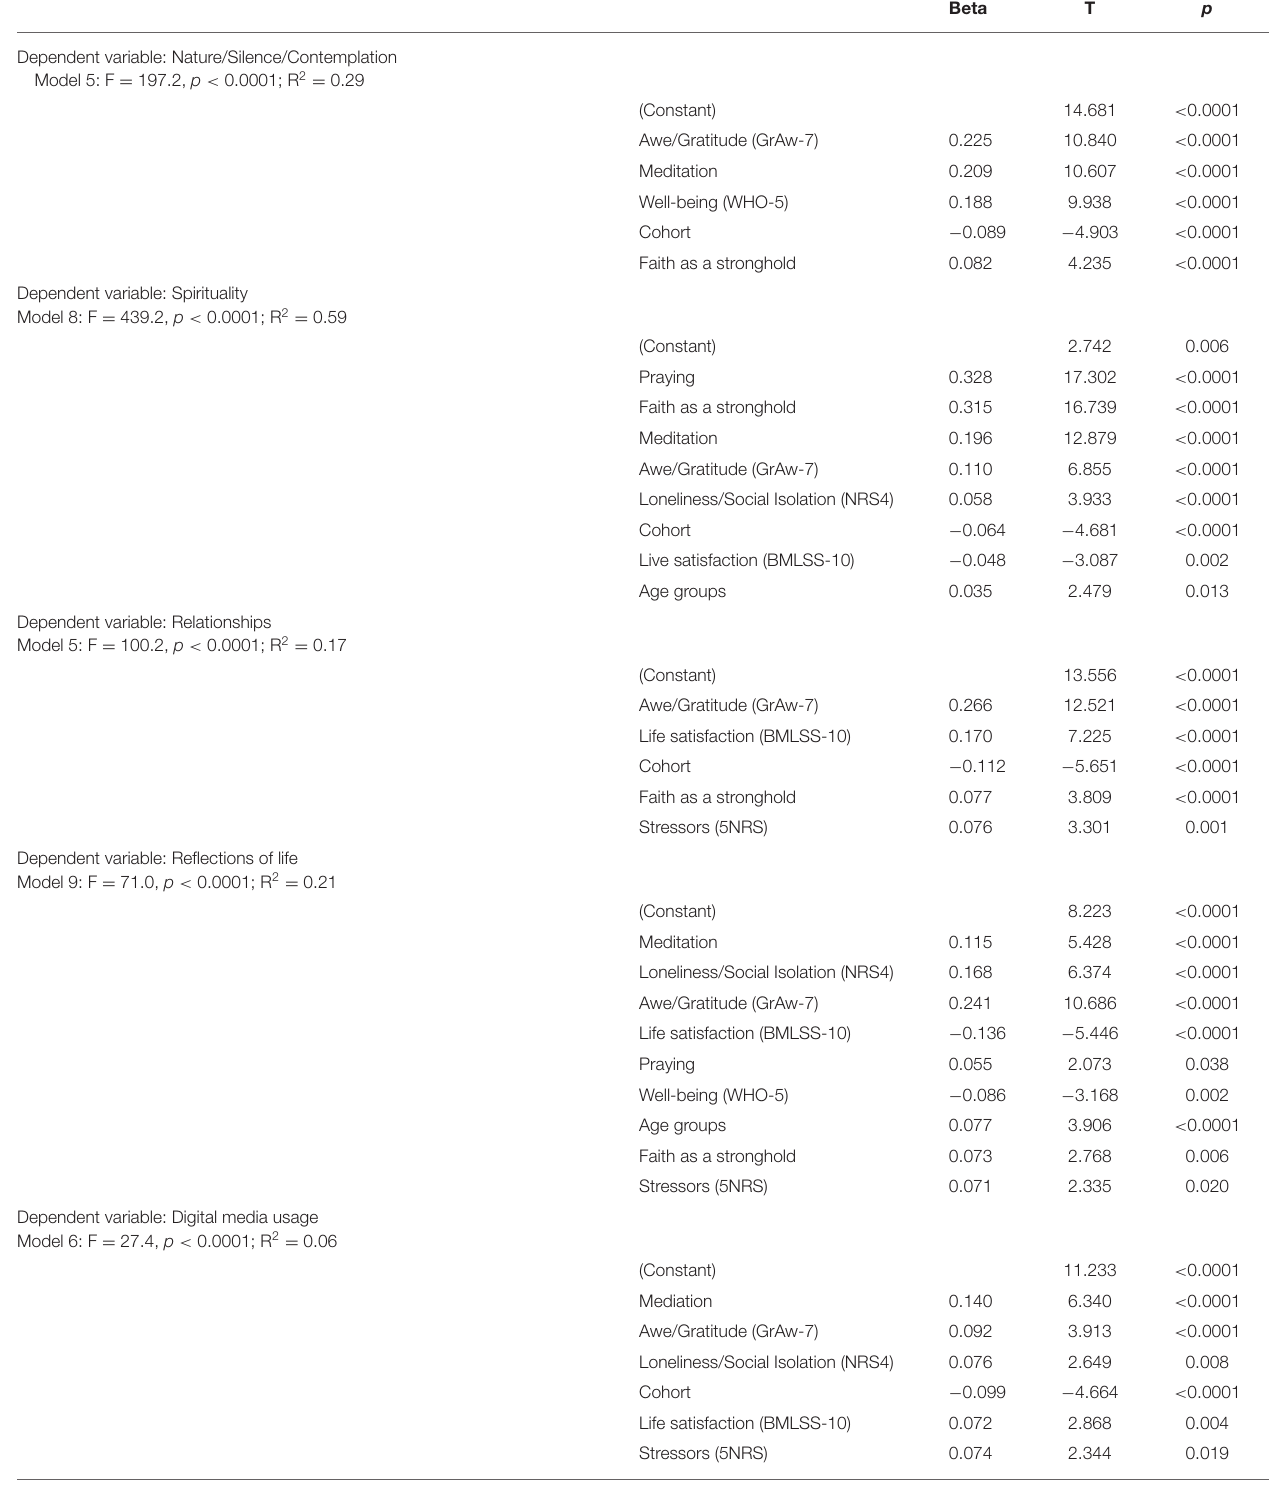
TABLE 7 | Predictors of perceived changes (stepwise regression analyses).